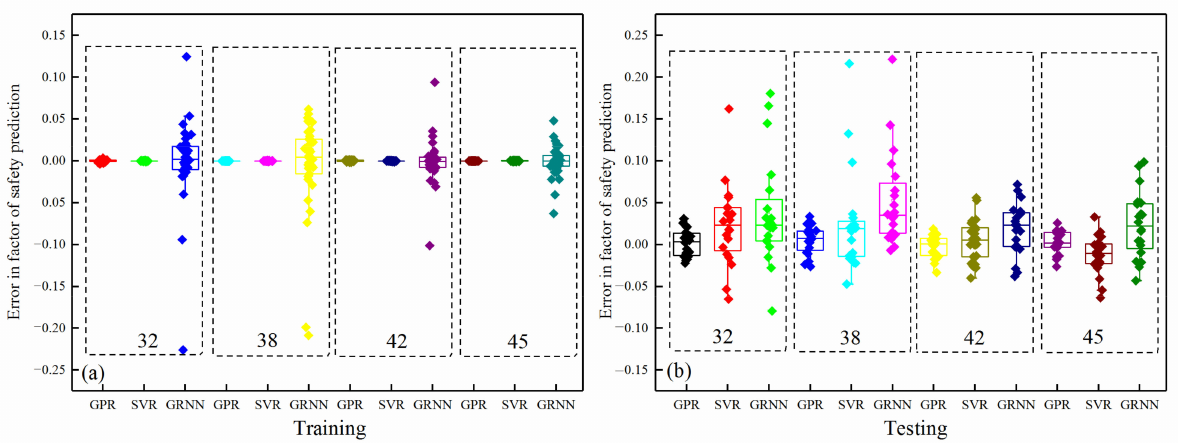
Figure 7. Case 1: Errors of factor of safety obtained from GPR, v -SVR, and GRNN methods by employing ( a ) training points; ( b ) testing